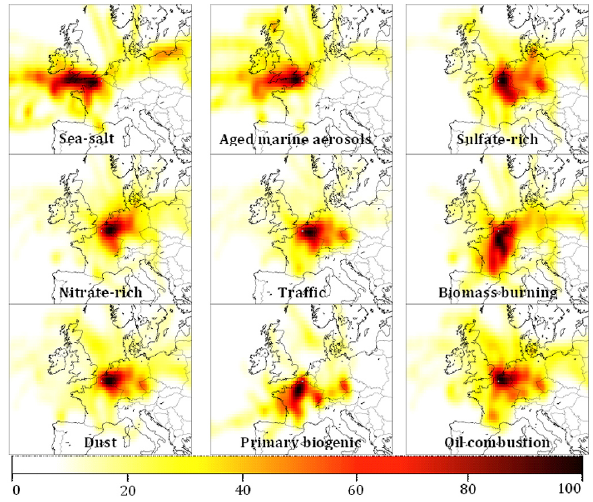
Fig. 7. Normalized PSCF values (in %) for all the identified sources in